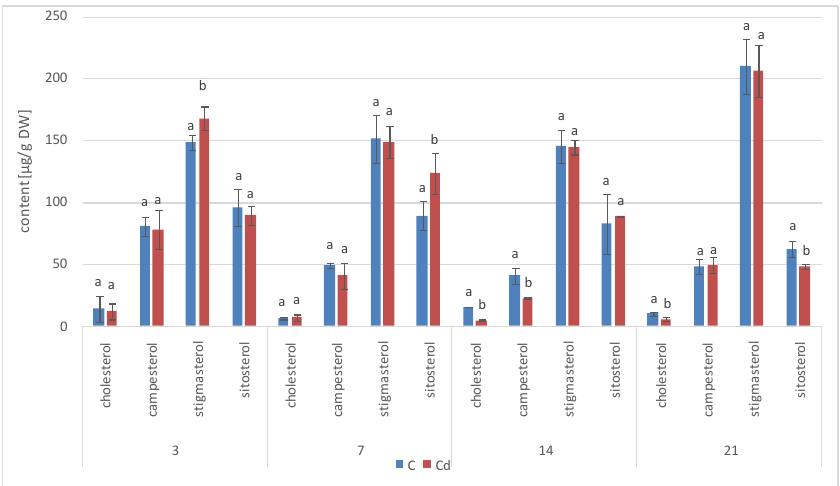
Figure 8. The effect of cadmium treatment on the content of sterol glycosides. Bars which do not share a common letter are significantly different ( p < 0.05).